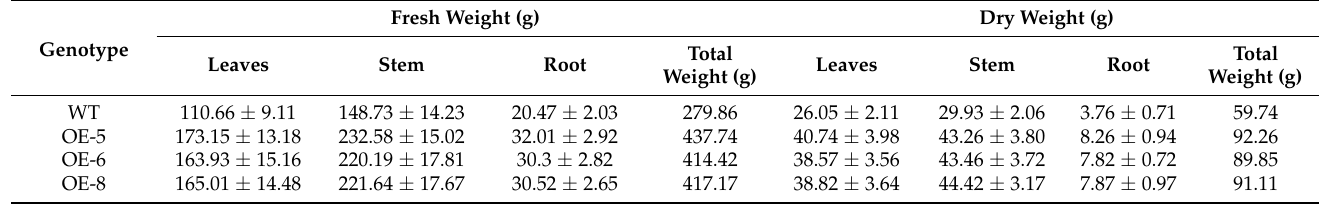
Figure 4. Analysis of root morphological and seed production in transgenic plants. ( a – c ) Comparison of roots morphological between wild type and GhKTI12 transgenic plants. ( d ) Total number of capsules per each plant (n = 10). ( e ) Seed yield per individual tobacco plant (n = 10). Bars in the graph show the standard mean error. Asterisks indicates significant differences between wild type (WT) and GhKTI12 transgenic plants analyzed by Student’s t -test p < 0.01 (**). Data were collected from 10 representative plants. Table 1. Comparison of biomass production between GhKTI12 transgenic and wild type (WT) tobacco